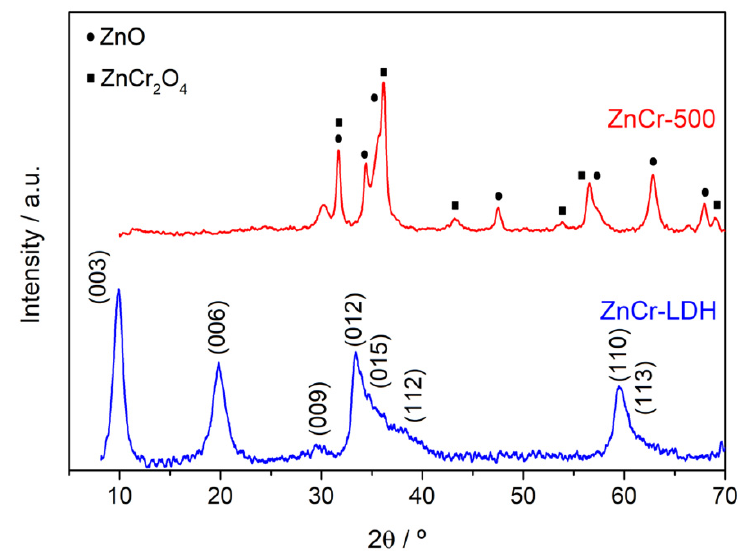
Figure 1. X-ray diffraction patterns for ZnCr-LDH and ZnCr-500 samples. For this type of material, the interlayer space corresponding to d003 is evaluated at 8.857 Ǻ , which can be assigned to the intercalation of nitrate ions and the extent of hydra- tion between the inorganic lamellae. The cell parameters are commonly evaluated so that c = 3d (003) = 26.571 Å and a = 2d (110) = 3.094 Å. The value a is equivalent to the mean metal cations in the layers.